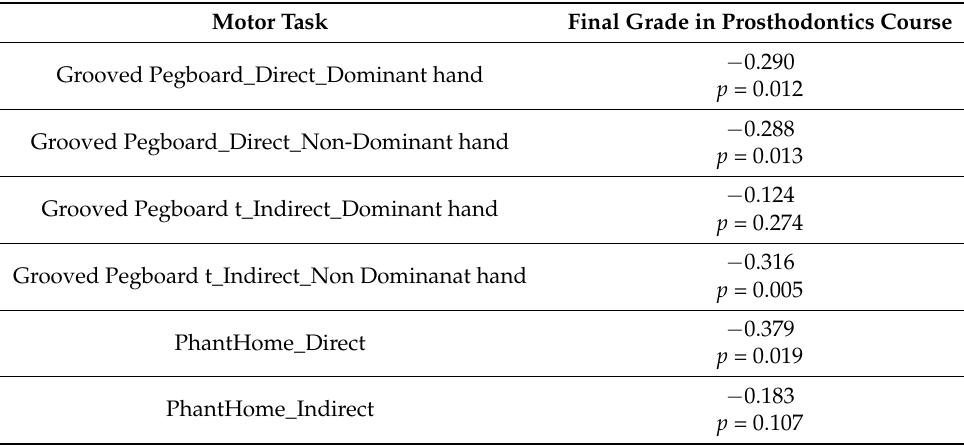
Table 2. Correlations between prosthodontic final grade and motor tests performed at time T0. Motor Task Final Grade in Prosthodontics Course −